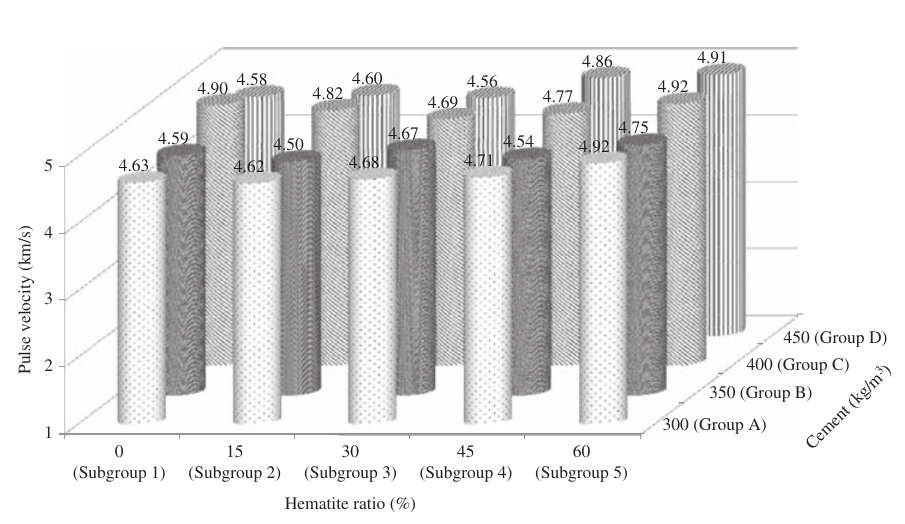
Figure 6 Splitting tensile strength of concretes.